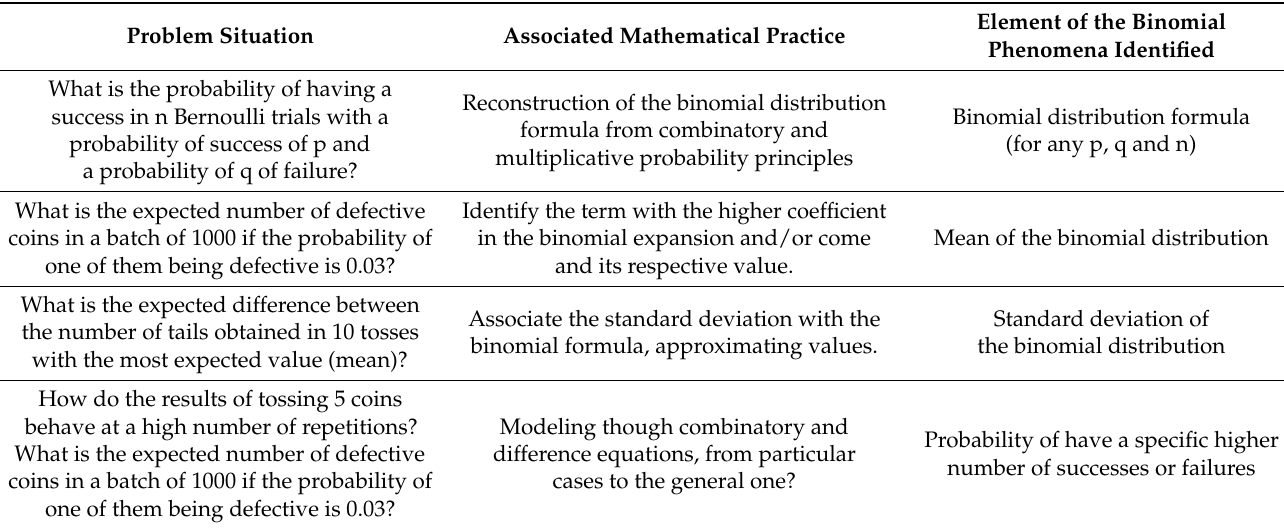
Table 10. How problem situations from historical problem situations (18th century onwards) could be proposed in the current